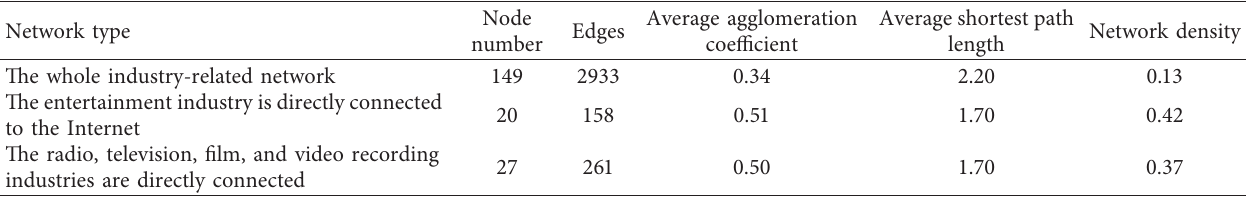
Figure 3: Diagram of direct industry connected network of broadcasting, television, film, and video recording production industry. Table 5: Statistical table of the overall structural characteristics of the industrial related